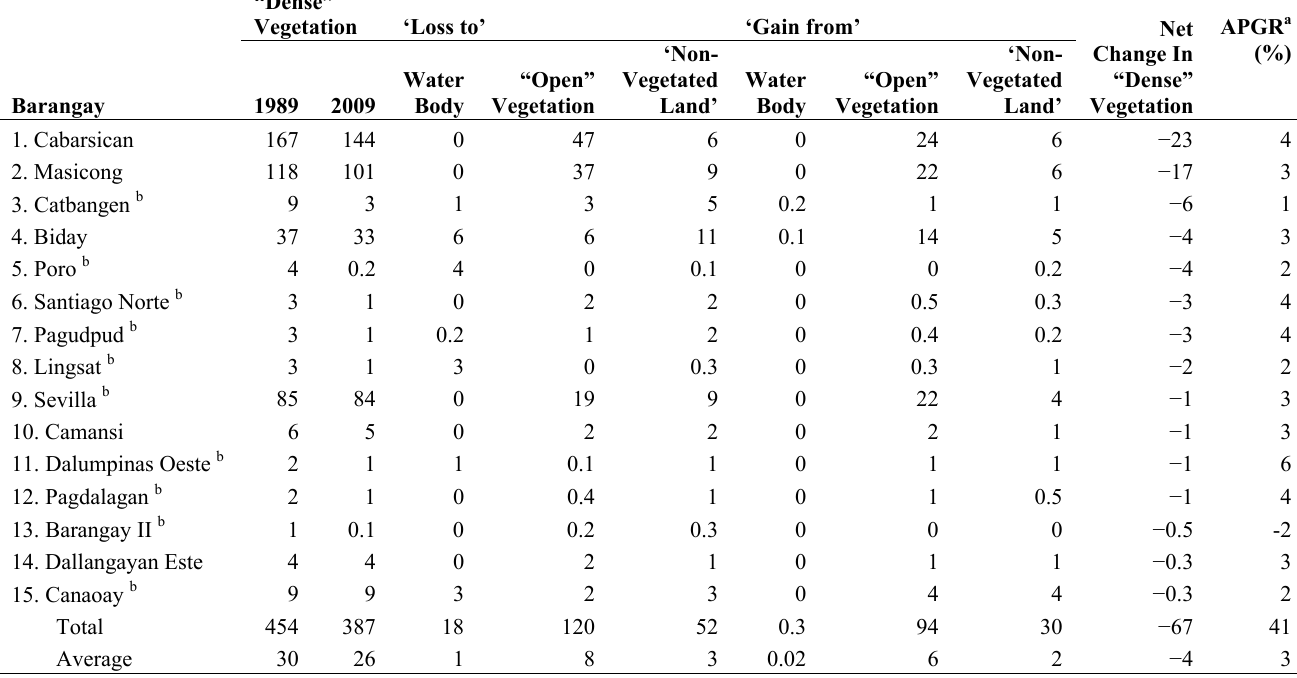
Table 7. The 15 barangays that lost ‘dense’ vegetation (1989–2009) (ha).